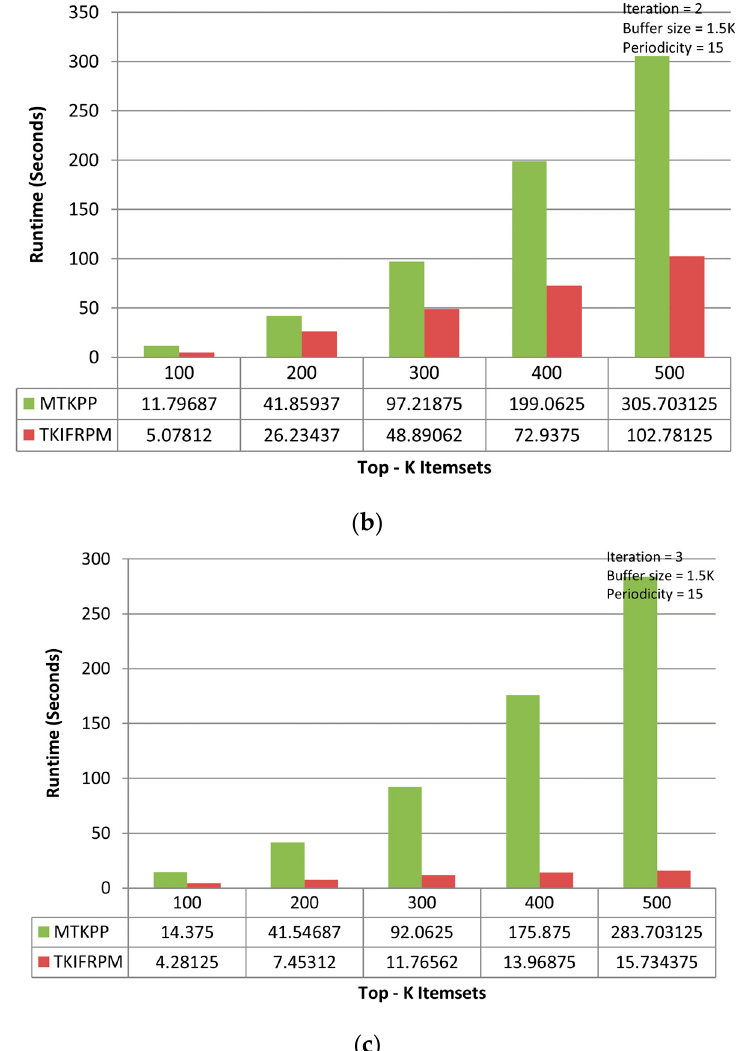
Figure 5. ( a ) Performance trends of the first iteration on the chess dataset. ( b ) Performance trends of the second iteration on the chess dataset. ( c ) Performance trends of the third iteration on the chess dataset.